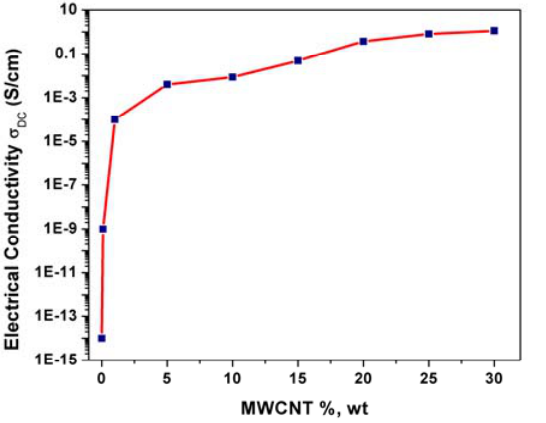
Figure 3. Four-point probe electrical conductivity as a function of MWCNTs content within epoxy